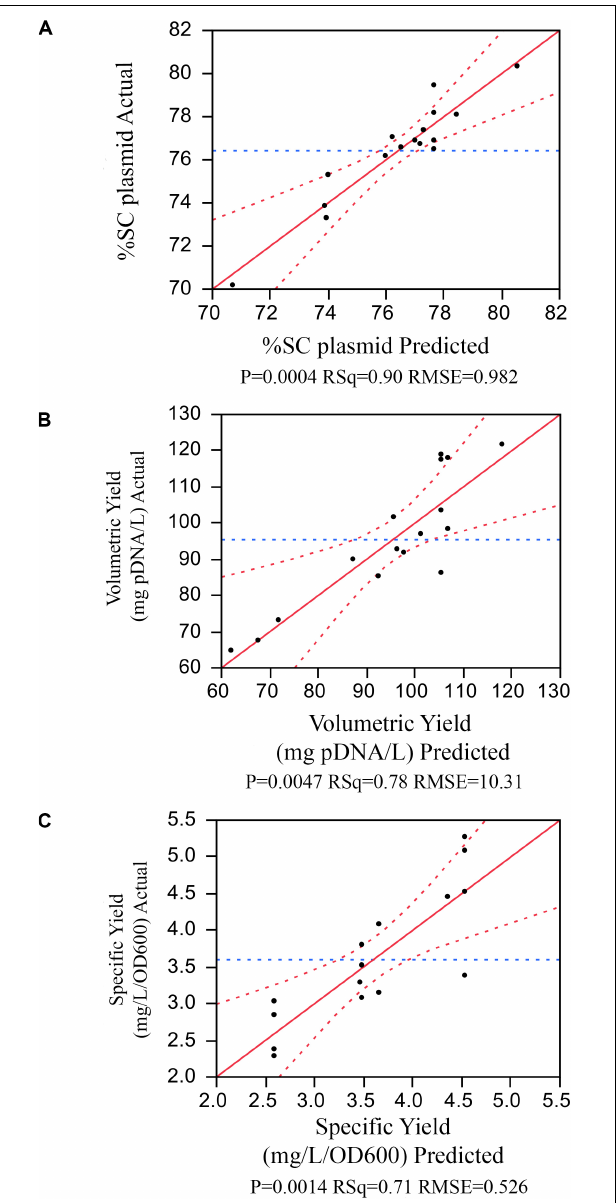
FIGURE 3 | The prediction plot by the actual plot for (A) %SC, (B) volumetric yield, (C) specific